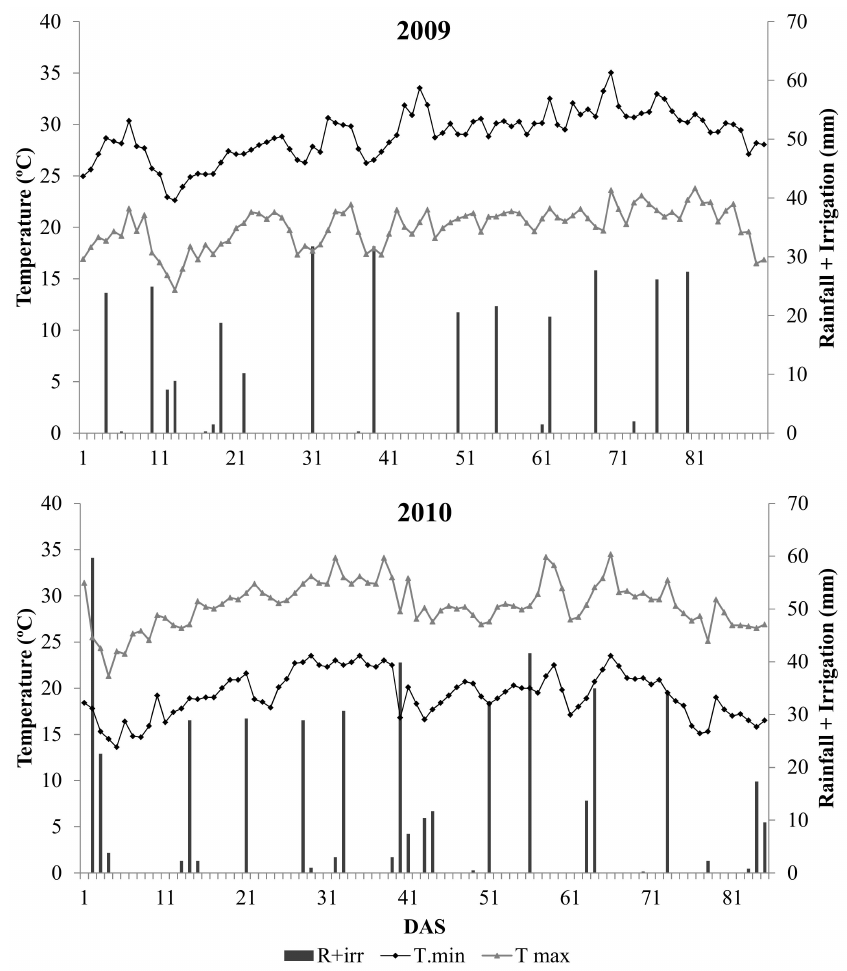
Figure 1. Monthly averages minimum (black diamonds) and maximum (gray triangles) air temperature and rainfall plus irrigation (bars) during the two contrasting grown